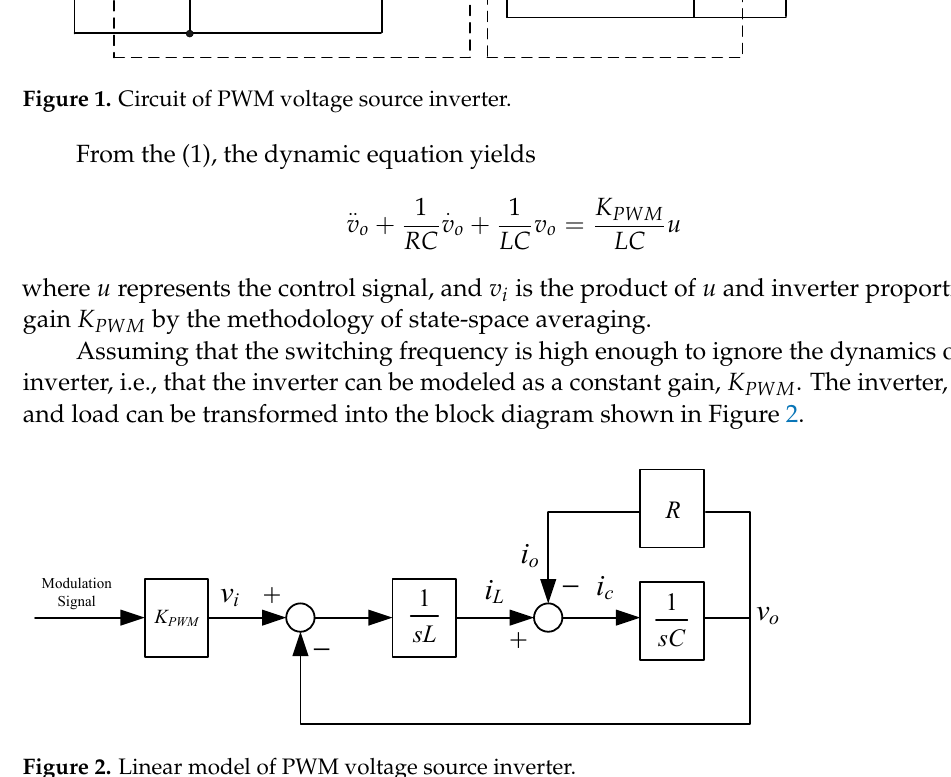
Figure 3. Block diagram of the PWM voltage source inverter with the proposed controller.